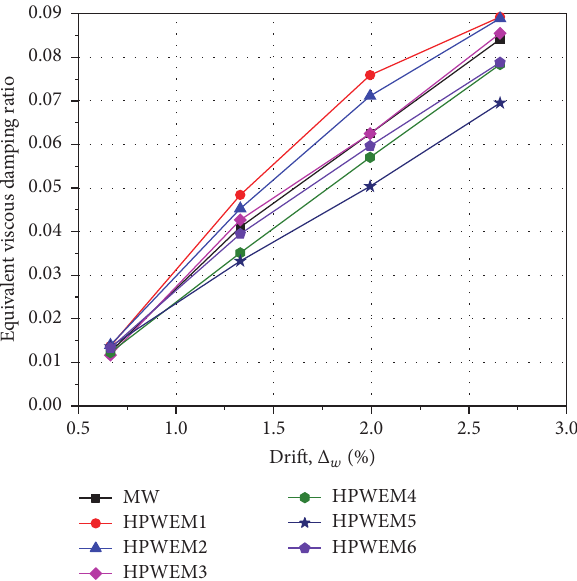
Figure 11: Energy dissipation curves.